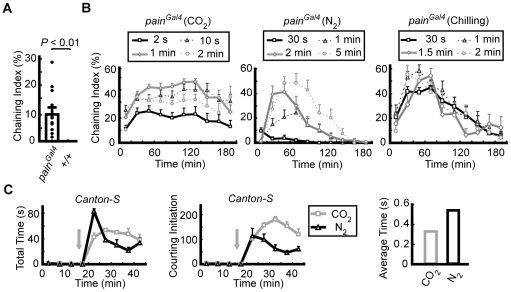

painless mutant males exhibited a male–male courtship behavior.(A) The average Chaining index (ChI) of 8–10 males that displayed spontaneous chaining behavior during a 10 min period in the morning (ZT0.5–ZT1.5). For both WT and painGal4males, more than six groups of males were analyzed. P<0.01 vs. the WT (Kruskal-Wallis test). (B) Average ChI of males recovered from the indicated anesthesia (top). Three different anesthetics were used in four different doses (indicated in the boxes above the traces). For each trace, 12 groups of males were observed every 5 min with a 15 min interval. (C) Average time spent by eight WT males on courting (left) and average time of courtship initiation (middle), before and after the indicated anesthesia treatments (grey arrows). Average time spent by the WT males on each courtship bout after anesthesia treatment (right). Values shown are means ± SEM.